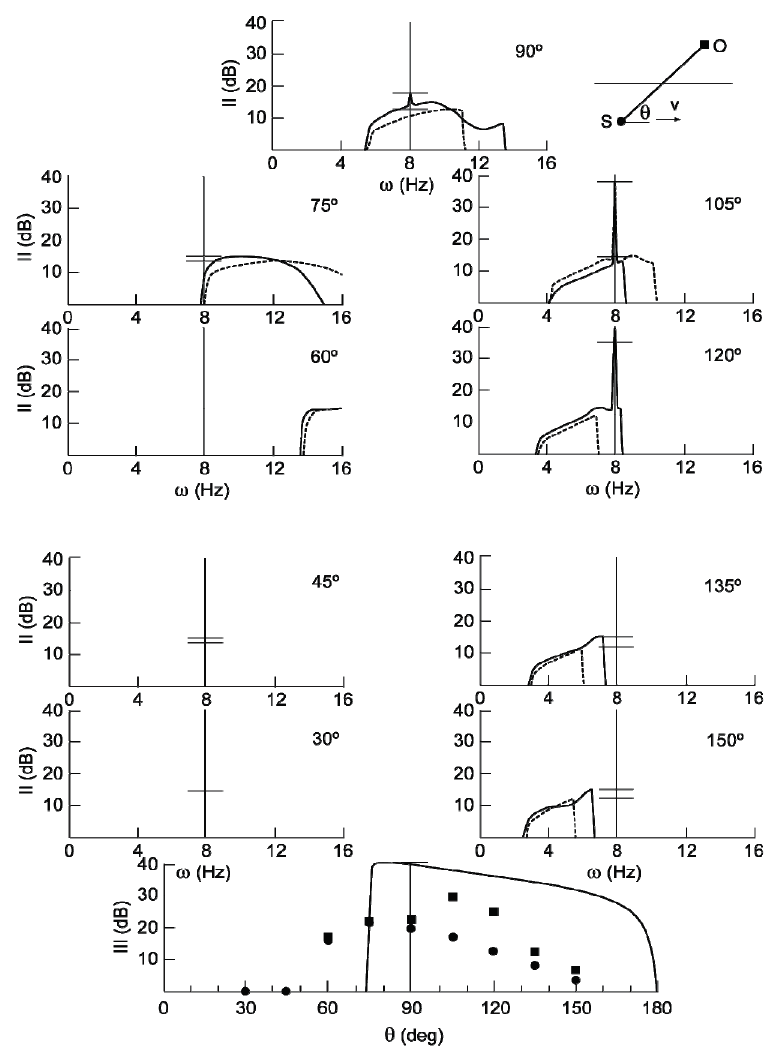
Figure 6. Spectra and directivity including a zone of silence. Noise received from a point monochromatic vertical dipole inside a jet by an observer outside after transmission across the irregular and turbulent shear layer. For a jet Mach number M = 2 a vortex sheet